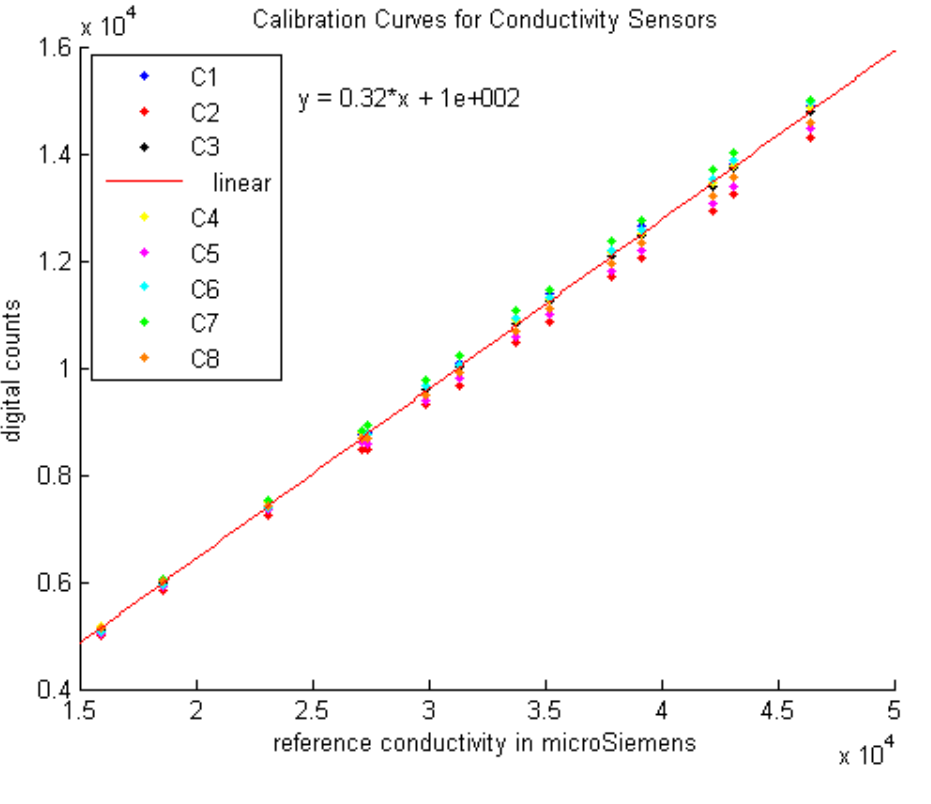
Figure 9. Conductivity calibrations for eight different DP loggers, with the best fit line for CT cell #3 shown in red along with its